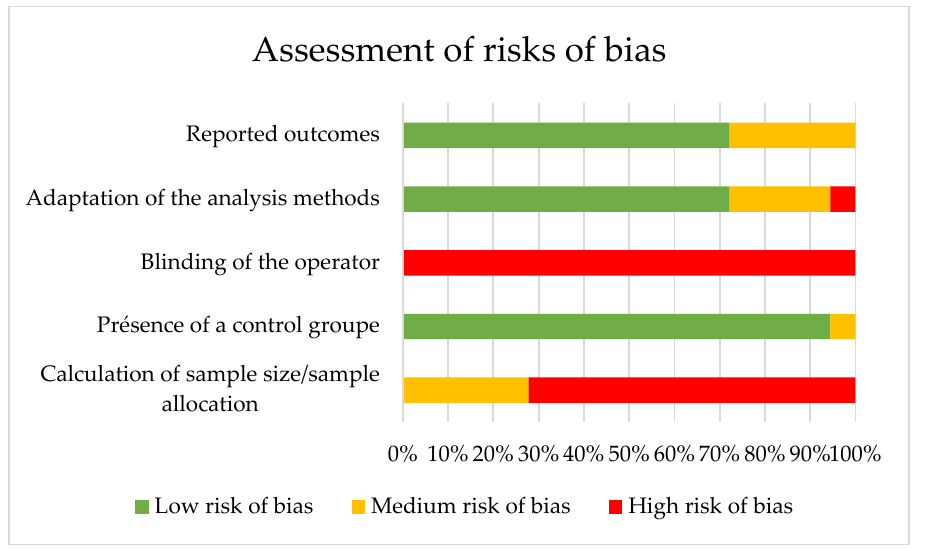
Figure 2. Risk of bias graph: authors’ assessment of each risk of bias item in proportions for all studies.